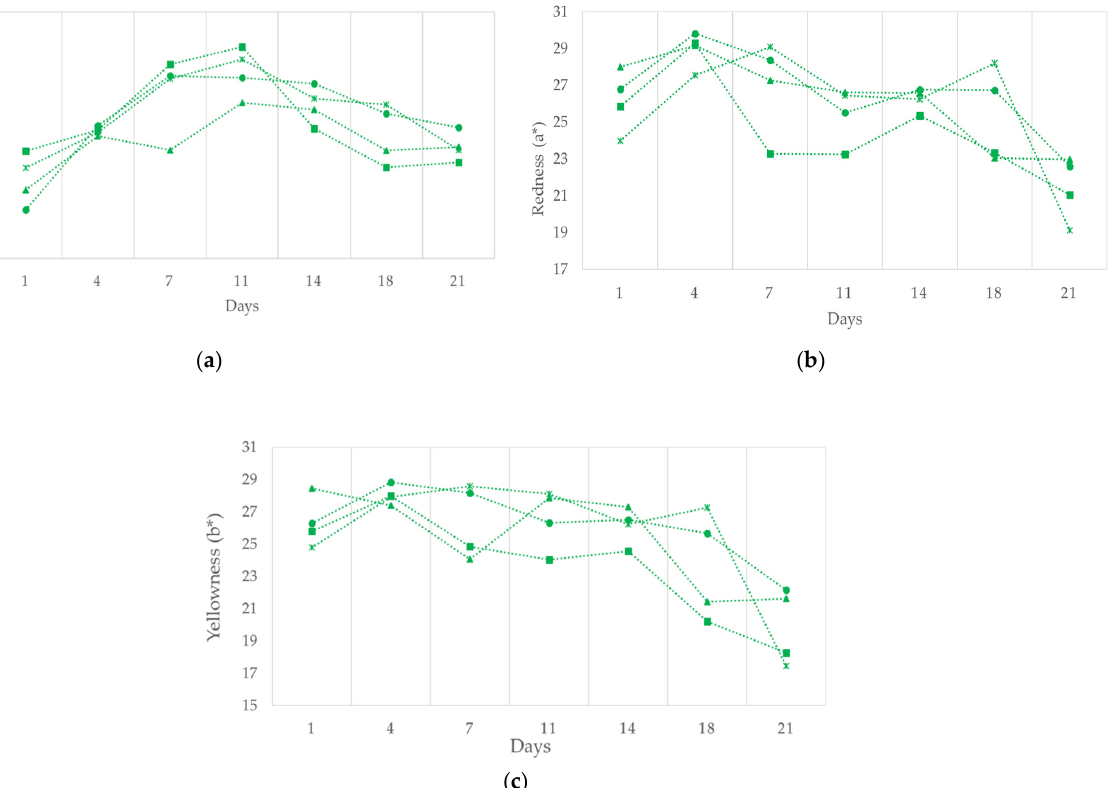
Figure 4. The effect of replacing pork backfat with high oleic sunflower oil on ( a ) lightness (L*), ( b ) redness (a*), and ( c ) yellowness (b*) in the reduced fat “Chorizo Zamorano” formulations during ripening. ( ■ ) Control, ( ▲ ) 12.5%, ( ● ) 20%, and (×) 50% of backfat replacement.